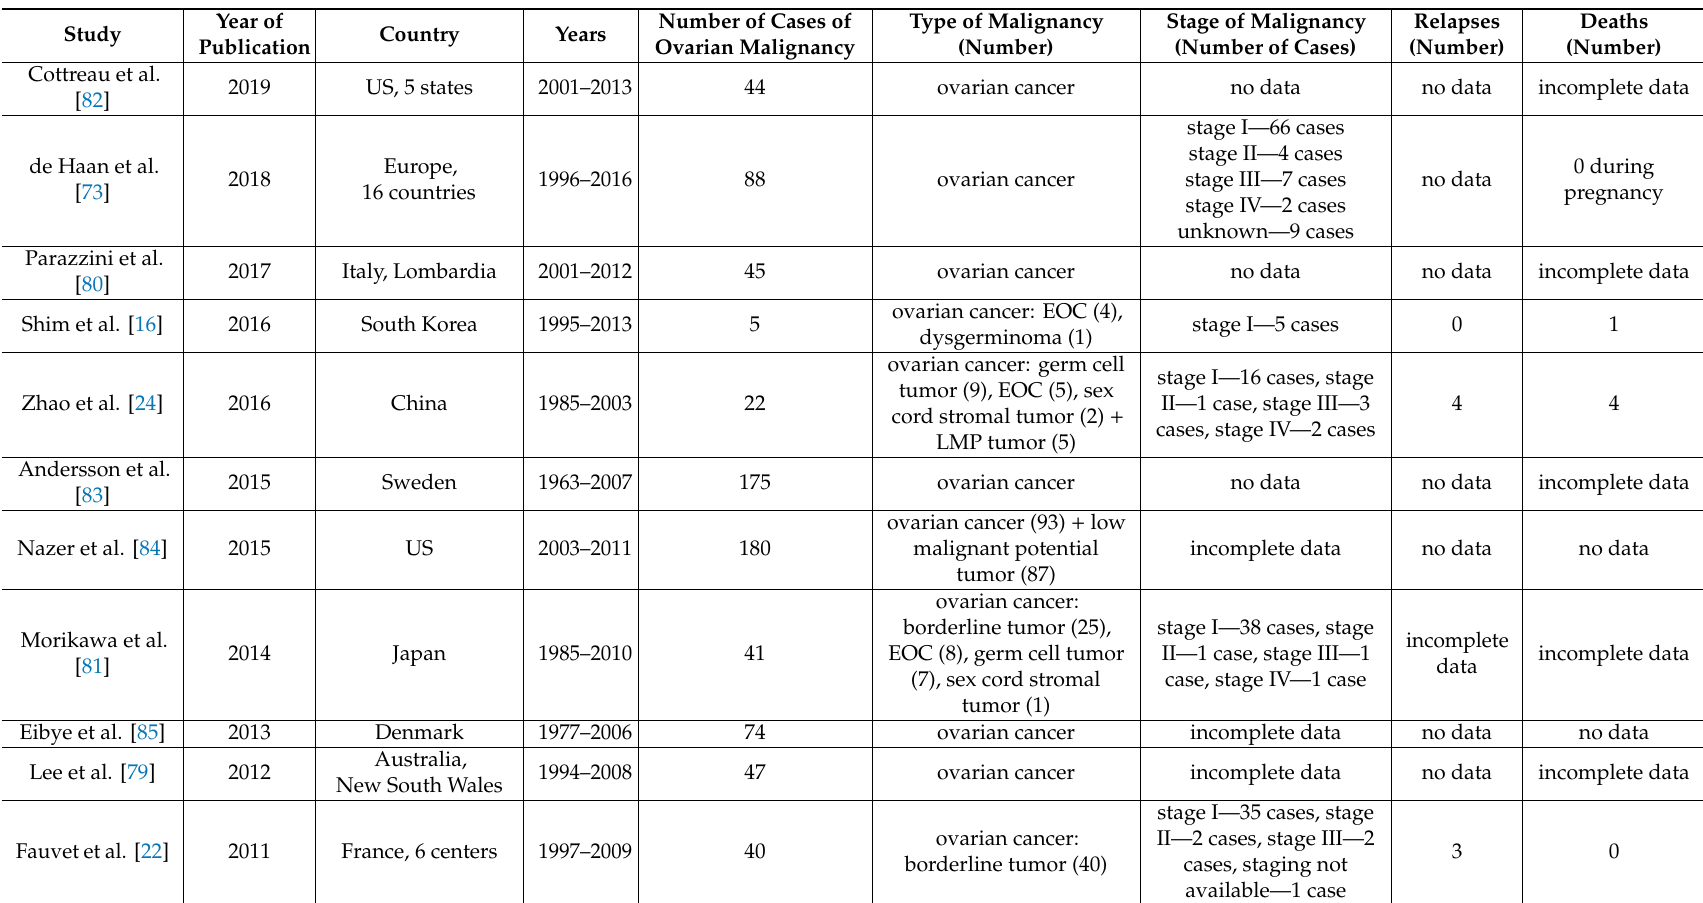
Table 5. Ovarian cancer in pregnancy in the literature and patient